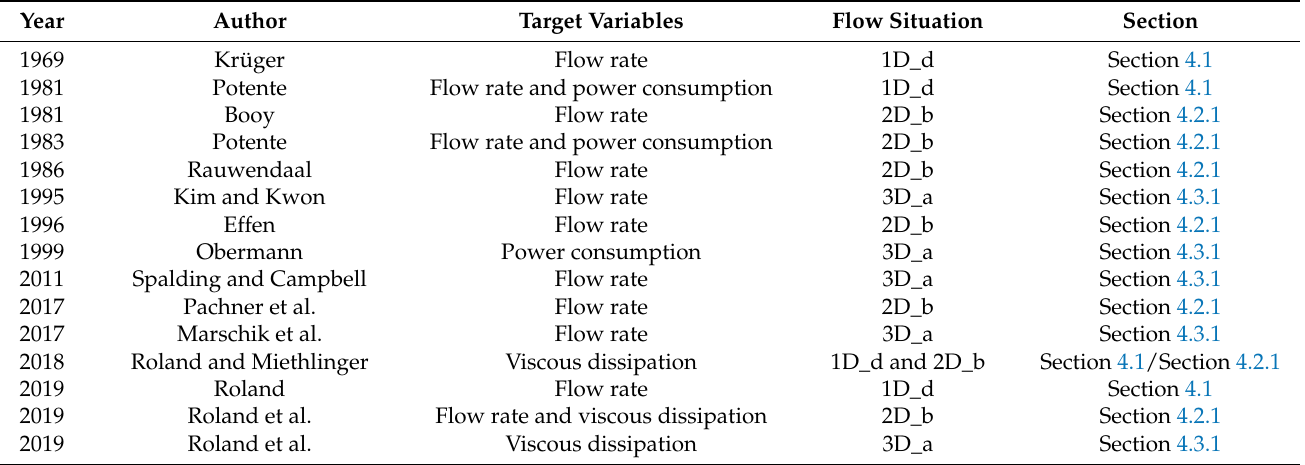
Table 5. Overview of approximate methods based on correction factors or analytical